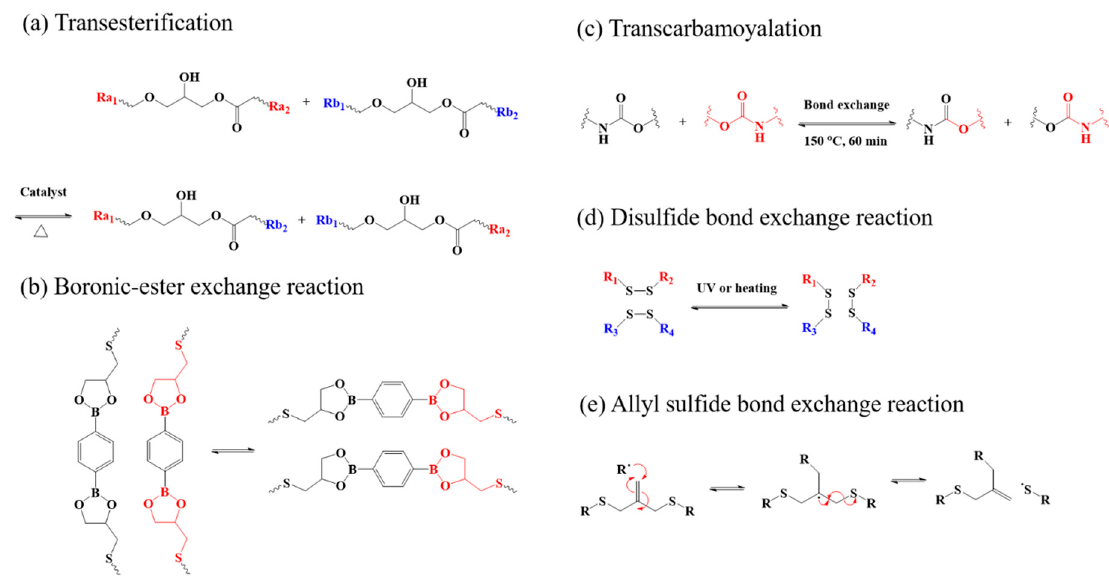
Figure 2. Dynamic covalent exchangeable bonds in LCPs. ( a ) Transesterification. [47] ( b )Boronic-ester exchange reaction [49]. ( c ) Transcarbamoyalation [48]. ( d ) Disulfide bond exchange reaction [50]. ( e ) Allyl sulfide bond exchange reaction [53].